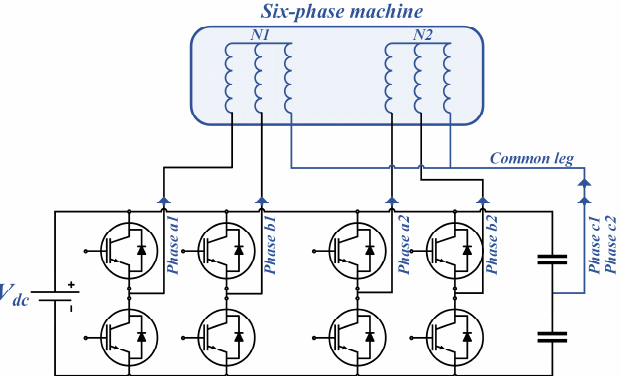
Figure 22. Structure of a four-leg inverter for a six-phase machine.